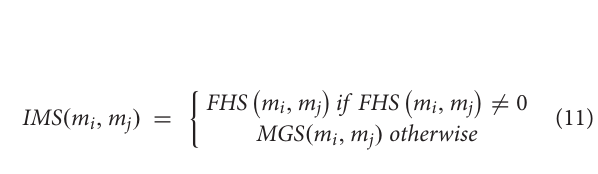
FIGURE 2 | A part of known metabolite–disease association